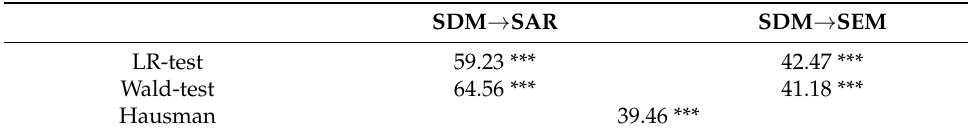
Table 7. Selection of spatial econometric